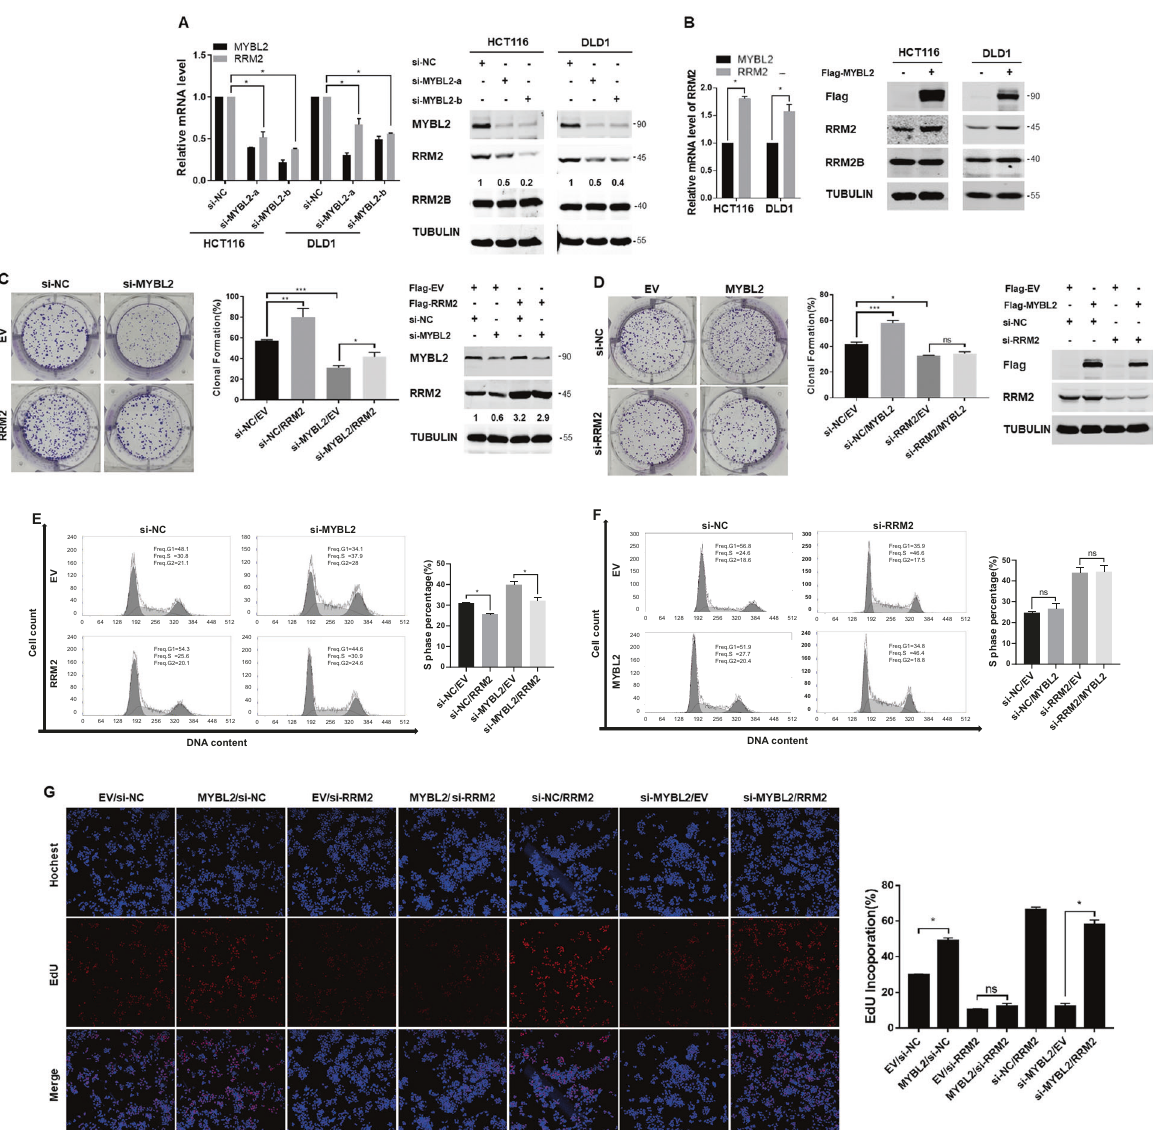
Fig. 2 MYBL2 was essential for proliferation, cell cycle progression, and DNA synthesis of CRC cells in dependence on RRM2. A, B The effects of knockdown or overexpression of MYBL2 on the expression of RRM2 in HCT116 or DLD1 cells. The mRNA levels were analyzed by qRT-PCR (normalized by actin), and the protein levels were detected by western blotting analysis with antibodies against MYBL2, RRM2, RRM2B, and TUBULIN (as loading control), respectively. C, D The proliferation of DLD1 cells determined by clonal-formation assays after the indicated treatments (overexpression or knockdown). The ef fi ciency of transfection or knockdown in DLD1 cells was determined by western blotting (right panels). E, F The cell cycle distributions of DLD1 cells was detected by FACS analysis after the indicated transfection or knockdown. G The DNA synthesis was measured by EdU incorporation assays in DLD1 cells after the indicated transfection or knockdown. Scale bars: 250 μ m, unpaired Student ’ s t -test (two-tailed) was used to analyze the signi fi cance between different groups. ns, not signi fi cant; * p < 0.05; ** p < 0.005, *** p <